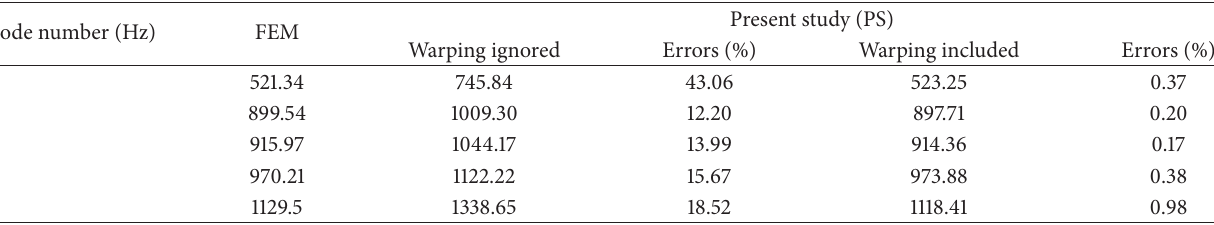
Table 2: Comparison of the first five frequencies of the spring.